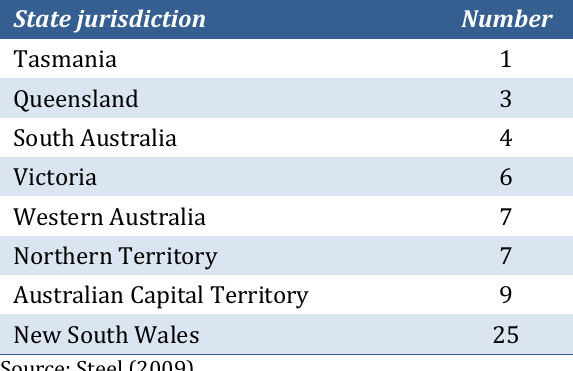
Table 1: Number of ‘punitive’ changes to bail legislation, 1992 ‐